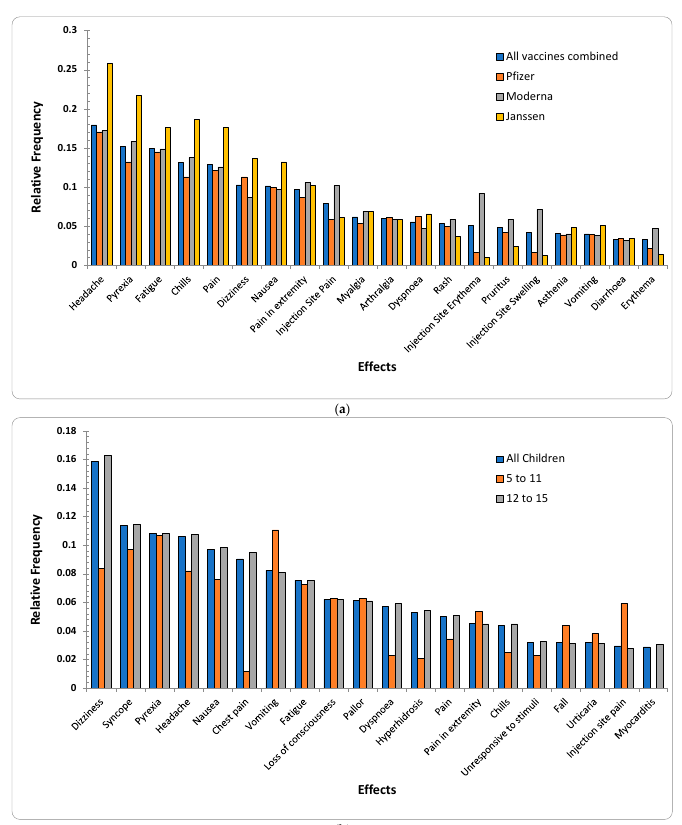
Figure 1. ( a ) Relative frequencies of the top 20 AEs appeared in VAERS reports for all age groups per the three vaccine producers (Pfizer-BioNTech, Moderna, and Janssen). ( b ) Relative frequencies of the top 20 AEs appeared in VAERS reports for children (discretized age groups of 5–11 years). The subset { chest pain , Dyspnoea , hyperhidrosis , and myocarditis } was among the lowest-reported AEs for age group (5–11 years) in comparison to the AEs reported for the group 12–15 and other 16 most commonly reported AEs.